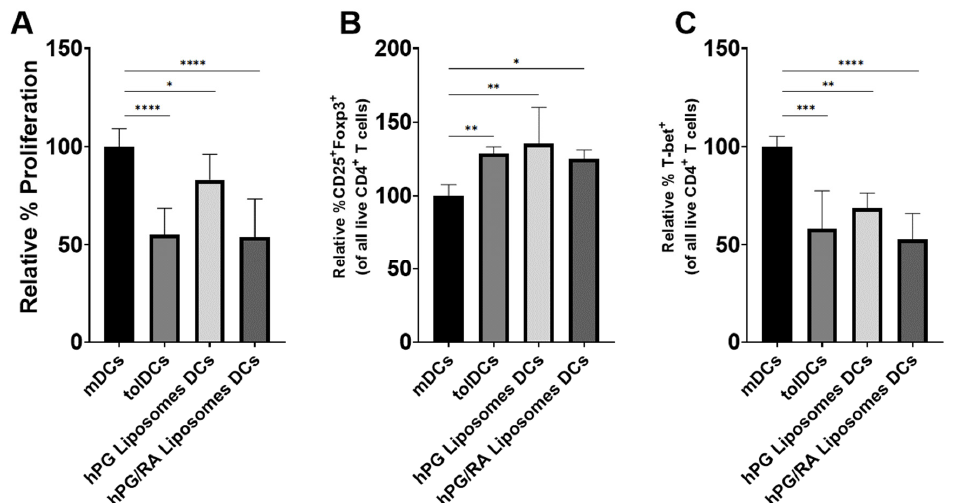
Figure 5. RA, free or encapsulated in liposomes, skew T cells towards a regulatory phenotype. BMDCs were stimulated with LPS and cultured in the presence of hPG (mDCs), hPG + RA (tolDCs) or hPG-containing liposomes with or without RA (hPG liposome DCs and hPG/RA liposome DCs, respectively). The hPG and RA concentrations were constant in all groups. After 24 h of incubation, the BMDCs were washed and hPG-TCR-specific CD4 + T cells were added. T-cell activation was analyzed by flow cytometry after 72 h of co-culture. ( A ) Relative % proliferated cells compared to mDC control. ( B ) Relative % CD25 + Foxp3 + and ( C ) % T-bet + in all CD4 + T cells, normalized to mDCs. Means + SD, **** p < 0.0001, *** p < 0.001, ** p < 0.01, * p < 0.05 compared to mDC determined by one-way ANOVA and Tukey’s multiple comparisons test. The data shown are combined normalized data from three independent experiments.